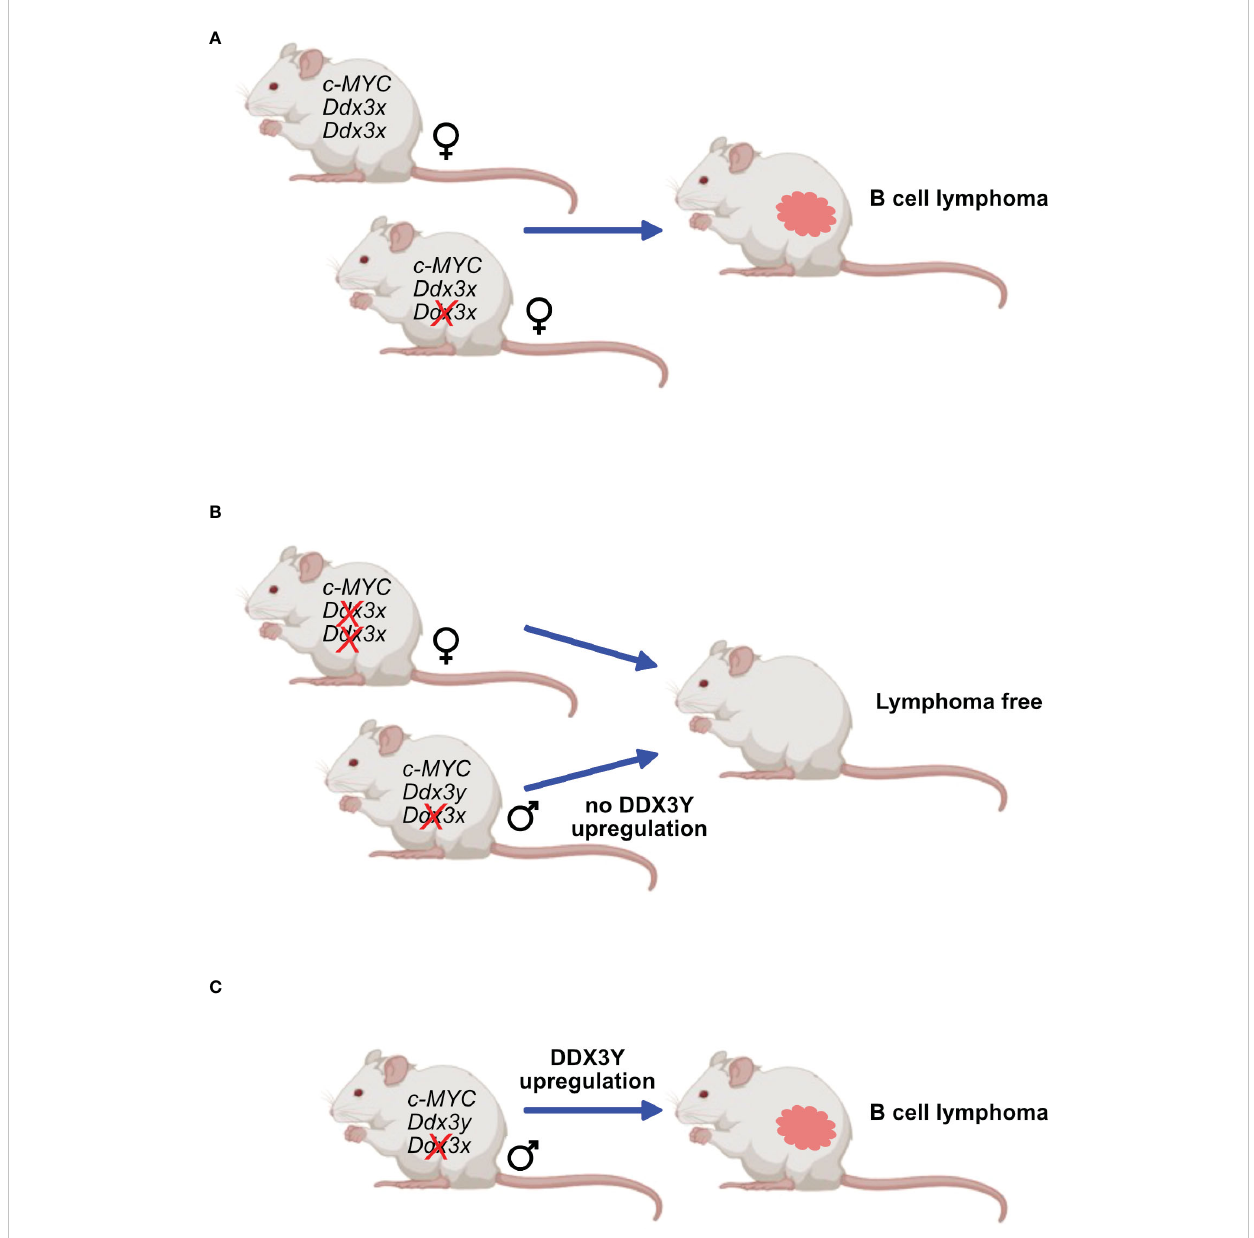
FIGURE 6 DDX3X and c-MYC in murine lymphomagenesis. Mice expressing transgenes that ensure a constitutive overexpression of c-Myc are prone to develop B- cell lymphoma. This process is not affected in females when only one Ddx3x allele is deleted (A) but is entirely abrogated when both Ddx3x alleles are lacking (B) . Males de fi cient for Ddx3x that retain the Ddx3y allele still develop lymphoma but must upregulate DDX3Y expression (C)